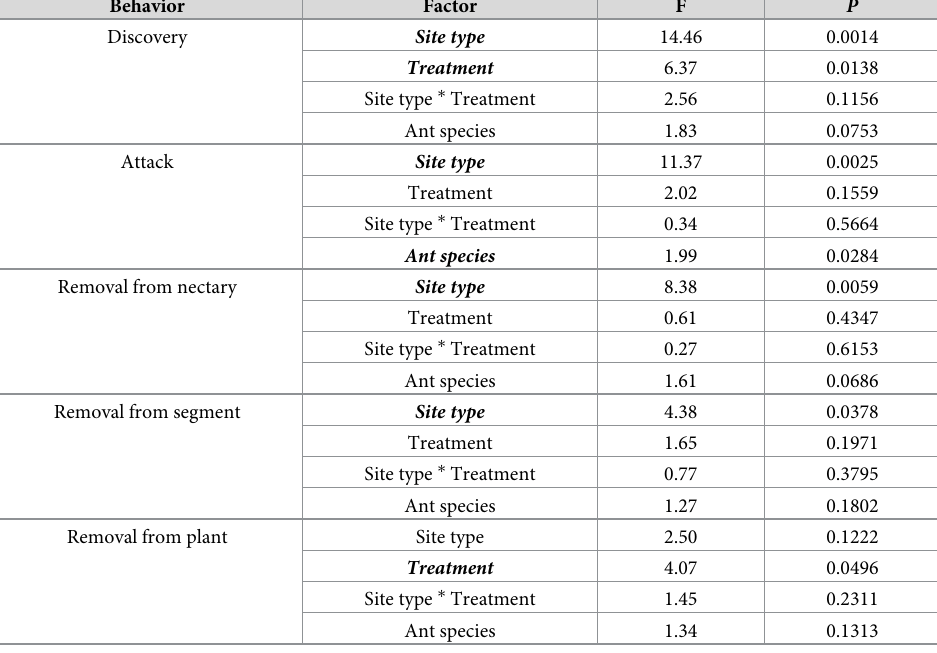
Significant factors are bolded and